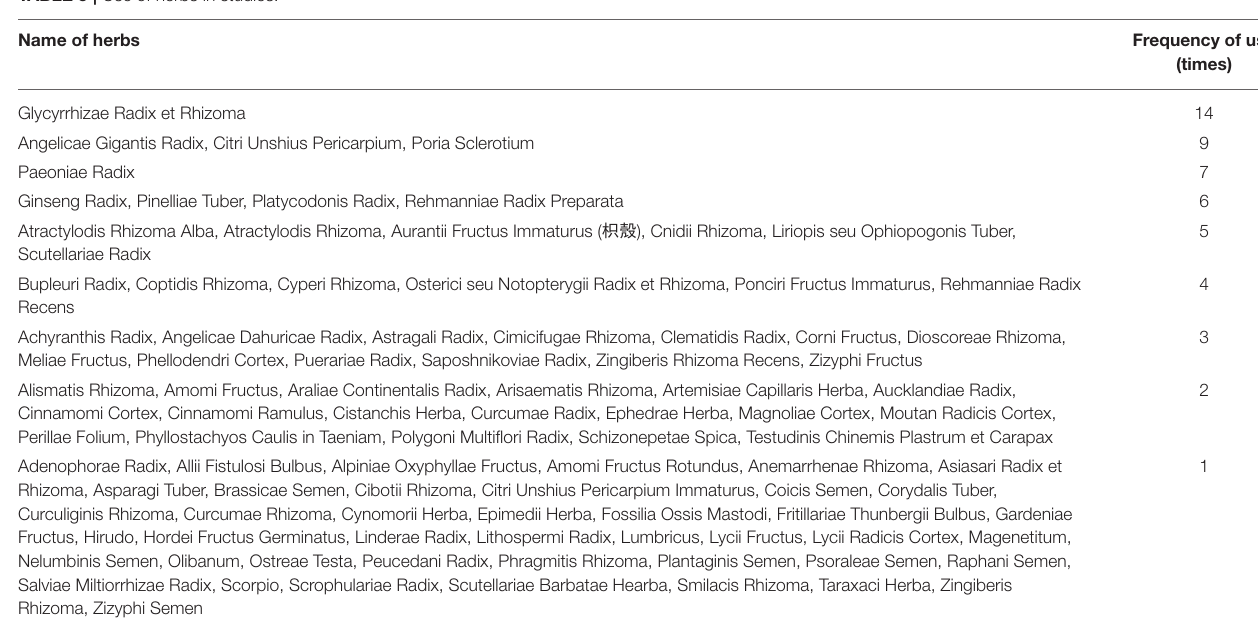
TABLE 5 | Use of herbs in